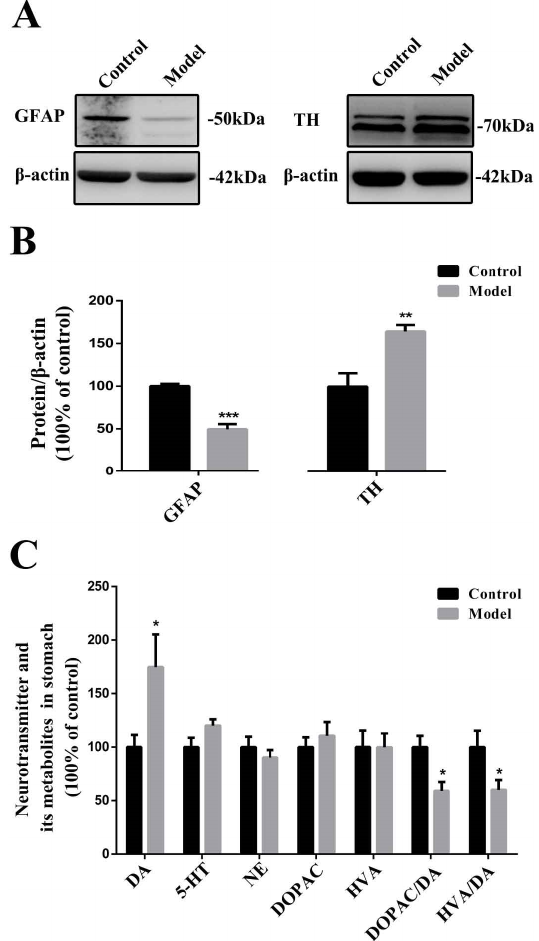
Figure 5. Chronic MPTP/p exposure may influence the functions of EGCs and TH-positive neurons in the stomach. ( A ) Representative protein bands detected using anti-GFAP, anti-TH, and β-actin antibodies are shown. ( B ) A histogram representing the quantitative analysis of protein levels detected using anti-GFAP and anti-TH antibodies normalized to β-actin protein levels is shown ( n = 4). ( C ) A histogram representing the levels of the main neurotransmitters and their metabolites in the stomach across groups is shown ( n = 7). The data are presented as the means ± SEM. * p < 0.05, ** p < 0.01 and *** p < 0.001 compared with the control group.